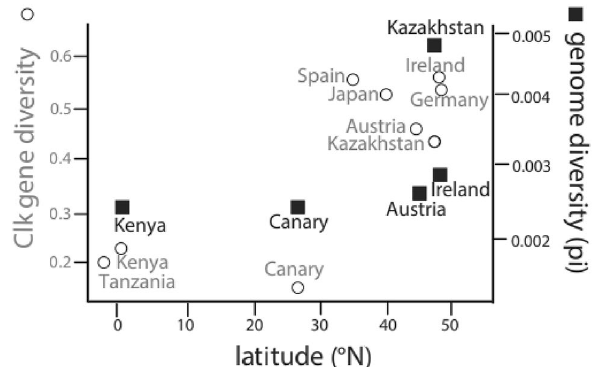
Figure 2. Clk locus specific and genome wide diversity of stonechat populations relative to breeding latitude. Gene diversity at the polymorphic Clk locus for the nine populations of this study is indicated by open circles (left axis); genome wide nucleotide diversity (autosomal pi) is plotted by black squares (right axis) for five populations with available genome wide statistics 54 . Clk gene diversity is lower in the African populations breeding at the equator than in the populations that breed at higher latitudes in Europe and